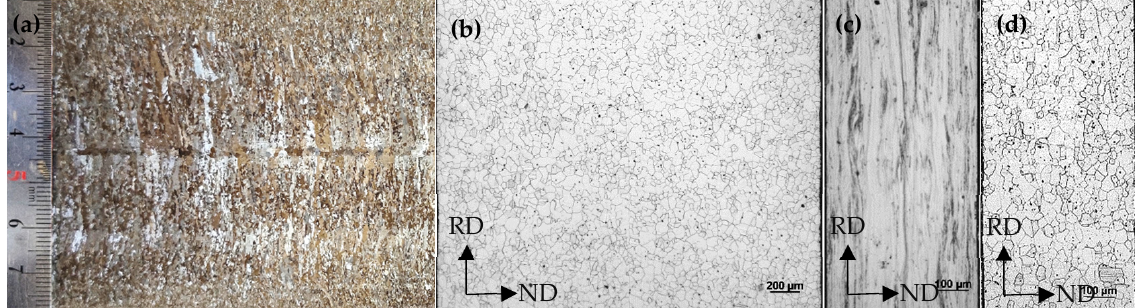
Figure 1. Microstructure morphology of CSP process Fe-0.65%Si non-oriented electrical steel billet ( a ), hot rolled band ( b ), cold rolled sheet ( c ) and annealed sheet ( d ). There is a certain degree of center segregation in the slab, and the inner and outer arc columnar crystals of the slab are fine and well developed, reaching the center. Microstruc- ture of the hot-rolled band after coiling at 700~720 °C is ferrite, with an average grain size of 35.9 μ m. Cold-rolled sheet is a fibrous microstructure with a width of 10~55 μ m, and there is a large number of shear band structures with an angle of 20~30° to the rolling direction. After annealing at 820 °C for 2 min, grain boundaries of the annealed sheet are clear and regular, and the average grain size is 27.9 μ m. Figure 2 shows the EBSD inverse pole figure (IPF) maps, micro-texture and macro- texture ODF cross-sectional view of Fe-0.65%Si non-oriented electrical steel. Figure 3 shows distribution of α and γ orientation lines and content of specific texture components of a hot-rolled band, cold-rolled sheet and finished sheet in Fe-0.65%Si non-oriented elec- trical steel.